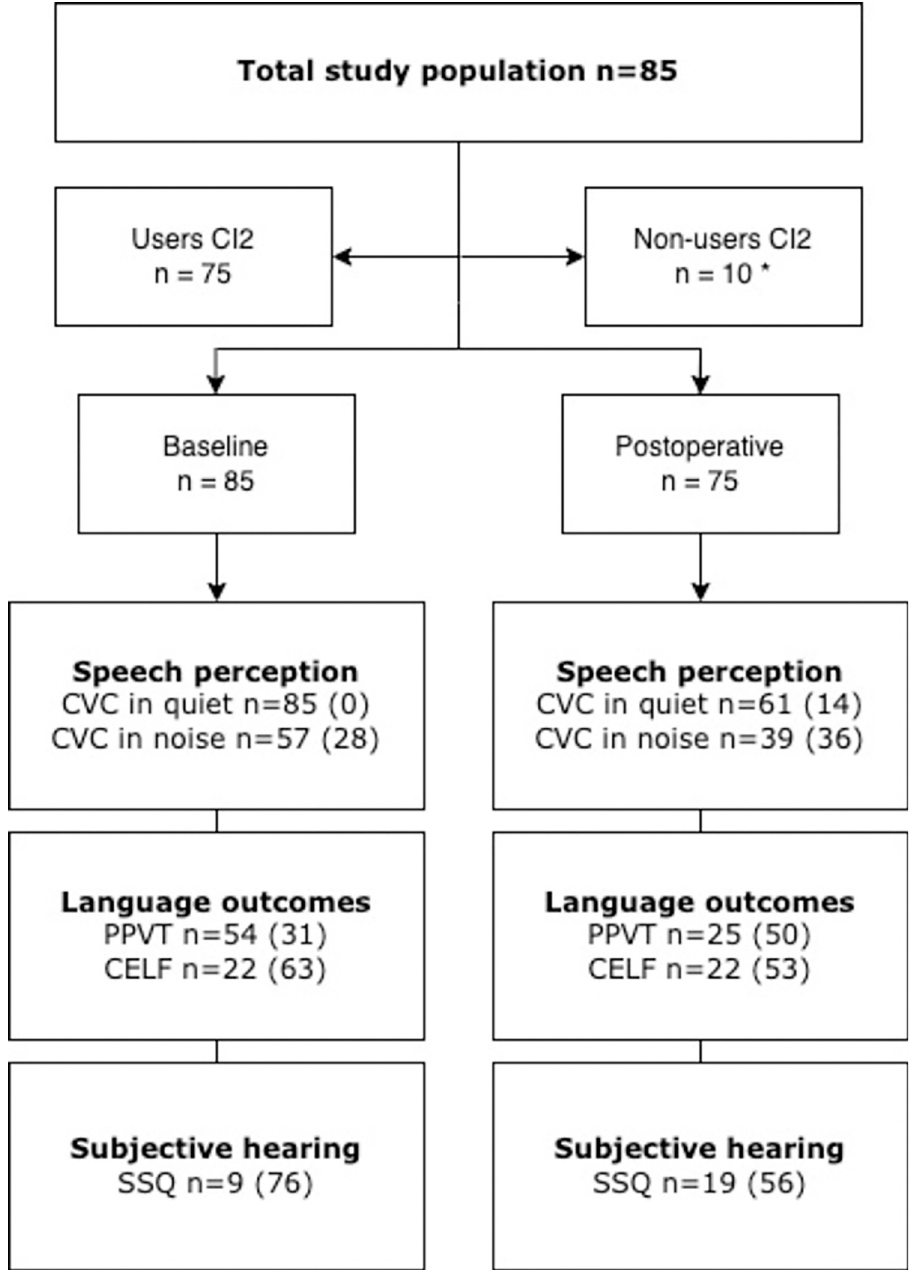
Fig 1. Flow chart of available test scores. Flow chart of study population and numbers of participants in analysis per outcome measure (in brackets missings per outcome) . Note : CVC = consonant-vowel-consonant; SSQ = Speech, Spatial and Qualities of Hearing Scale; PPVT = Peabody Picture Vocabulary Test; CELF = Clinical Evaluation of Language Fundamentals. � For the non-users no postoperative performance outcomes were measured by the non-use of CI2 in daily life